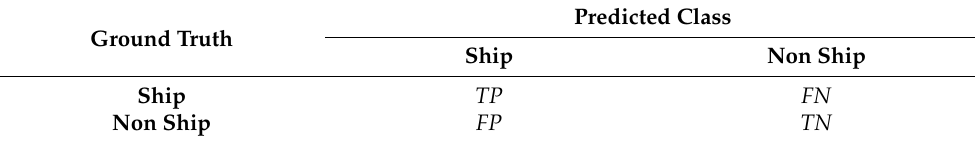
Table 4. Confusion matrix.